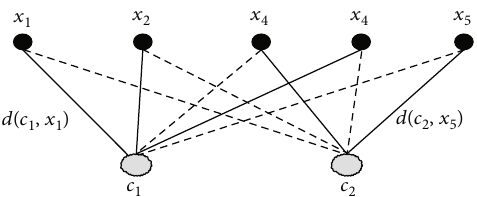
Figure 3: An example of the assignment for the target areas to